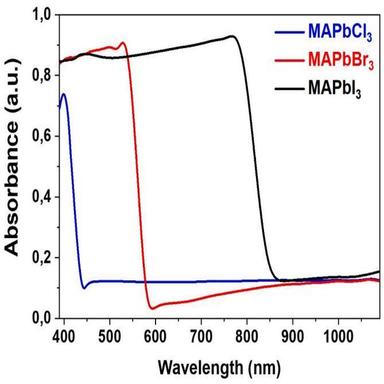
Optical absorbance spectra of the powders based on the MAPbX3 (X = I, Br and Cl) perovskites.